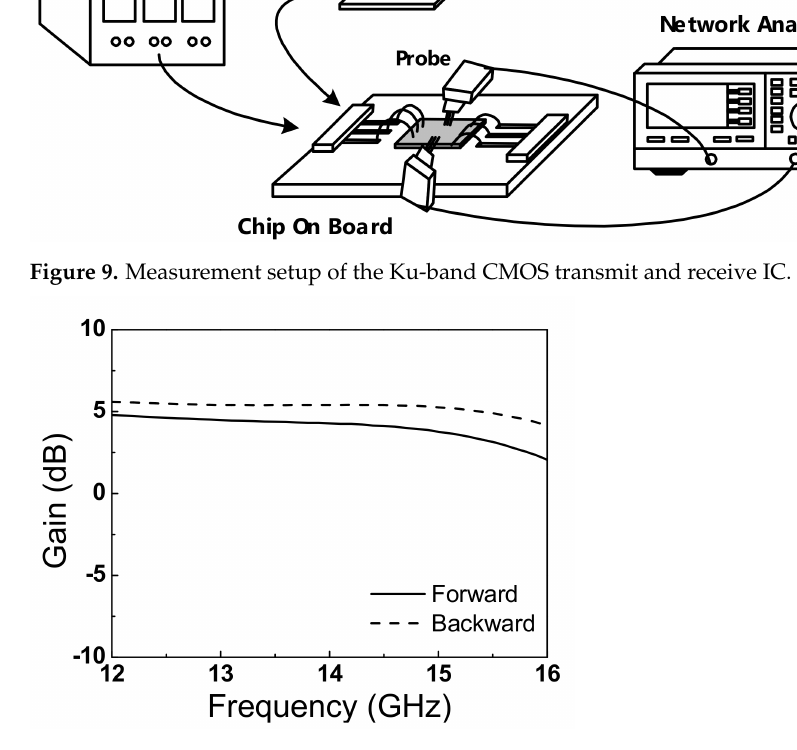
Figure 10. Measured gain of the Ku-band CMOS transmit and receive